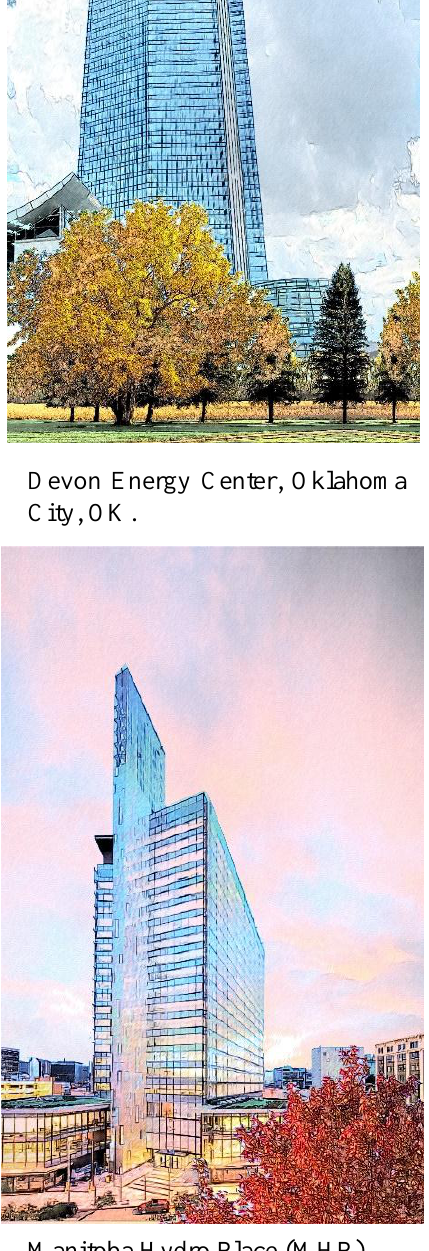
Figure 4. Cont. Figure 4.